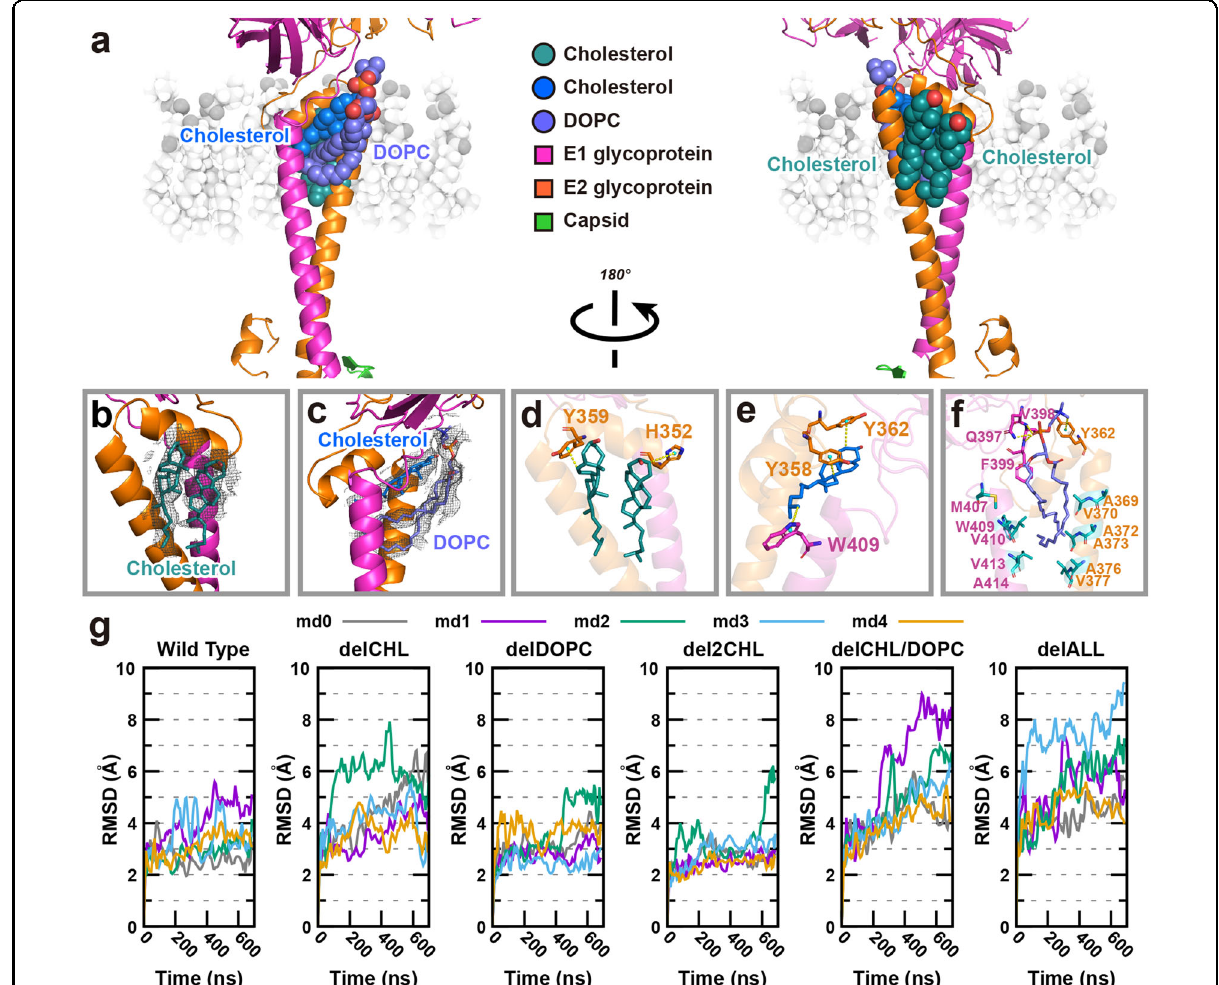
Fig. 7 Cholesterol molecules and a phospholipid DOPC in the hydrophobic pocket. a Overview of the distribution of cholesterols and a phospholipid molecule DOPC. Cholesterol (blue) and DOPC (slate) are in the hydrophobic pocket formed by the E1 TM helix, the E2 TM helix, and E2 domain D. The other two cholesterols (deep teal) are positioned on the other side of domain D. E1 and E2 are presented as cartoons. The involved cholesterols and DOPC are presented as spheres, and the outer lea fl et of the viral envelope membrane is shown in the background. b , c Zoomed-in views of cholesterols and DOPC molecules, which are shown as sticks. Cryo-EM densities attributed to the cholesterols and phospholipid are shown as mesh. d – f Zoomed-in views of the interactions between cholesterol or DOPC and E1 or E2. The aromatic residues positioned near the cholesterol or DOPC are shown as sticks with the same color as E1 or E2. The hydrophobic residues positioned near the tail of DOPC are shown as sticks. The center of mass of aromatic ring is shown as nb_spheres, colored in cyan. The yellow dashed lines represent the hydrogen bonds. A portion of the hydrogen bonds is CH – π hydrogen bonds between the soft acids CH and a soft base π -electron system. The remaining portion is common hydrogen bonds between the phosphate group of DOPC and Q397, V398 or F399. g Time evolutions from MD simulation analysis for the C α -RMSD of E1 (295 – 435) and E2 (269 – 422) for systems “ Wild Type ” , “ delCHL ” , “ delDOPC ” , “ del2CHL ” , “ delCHL/DOPC ” , and “ delALL ” . All curves were smoothed with the Bezier method, implemented in